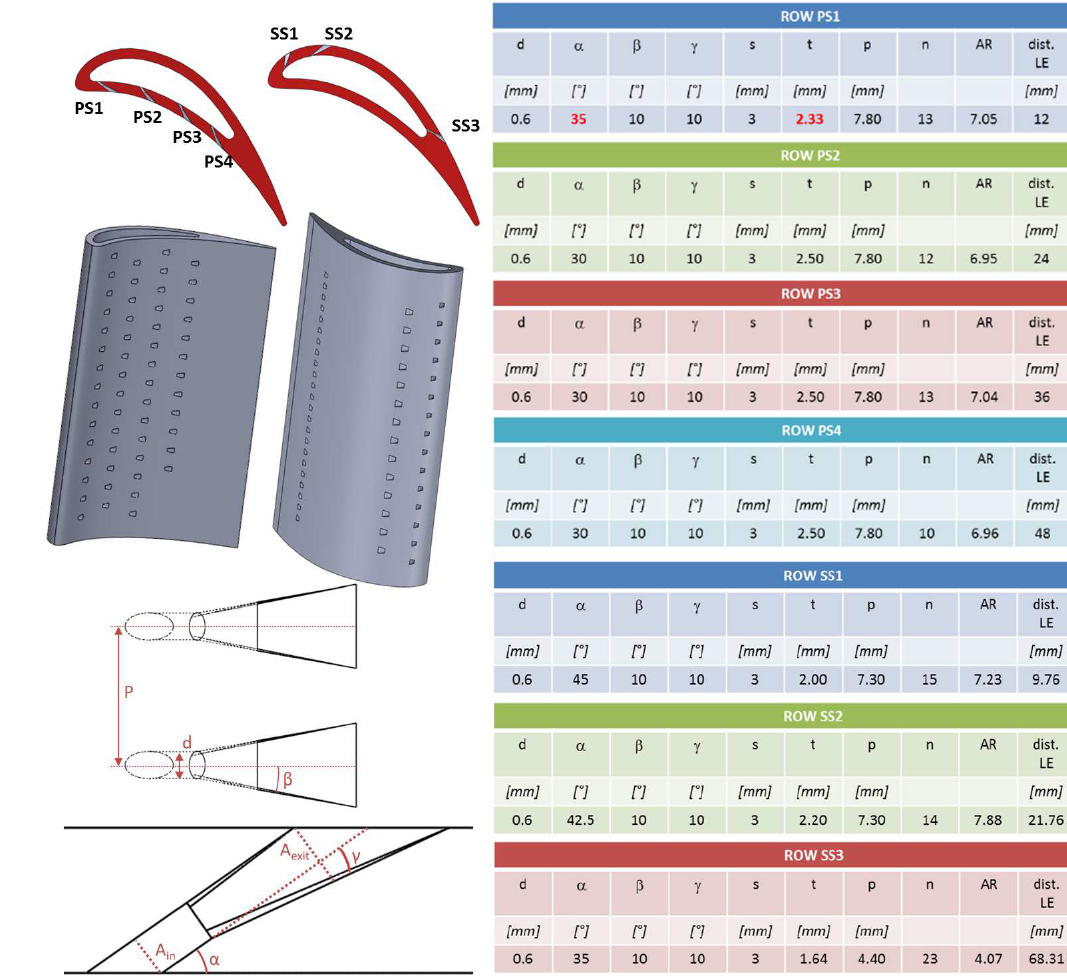
Figure 2. Vane models and geometric